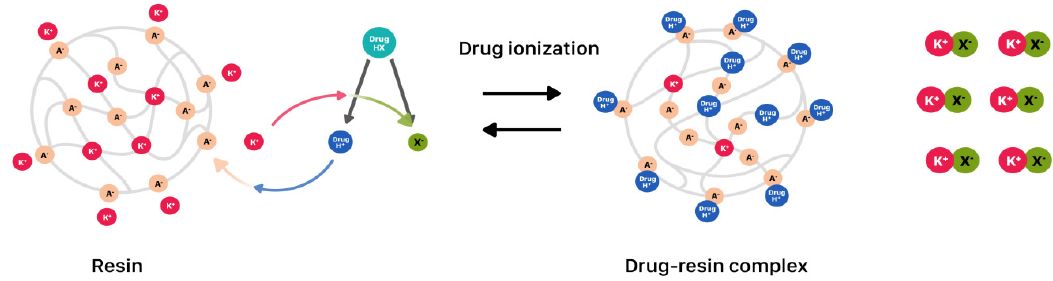
Figure 3. Drug release modification utilizing drug-resin complexes.